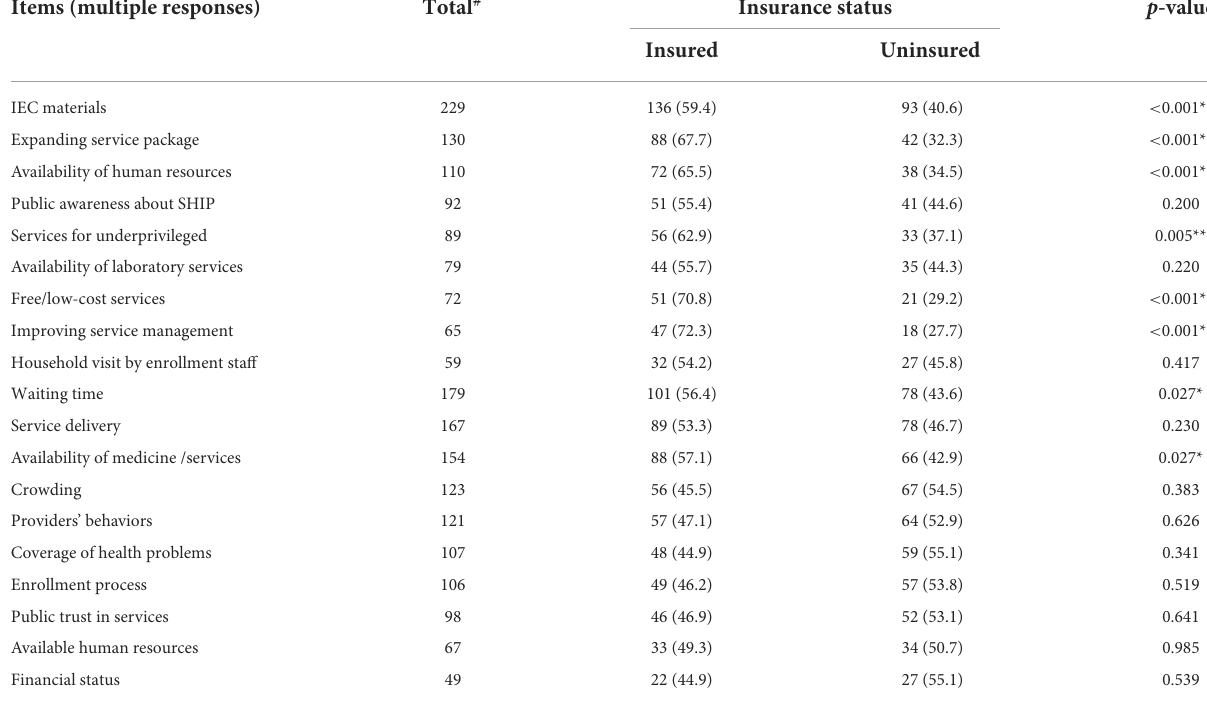
TABLE 5 Experiences of the insured and uninsured beneficiaries toward the SHIP and providers.